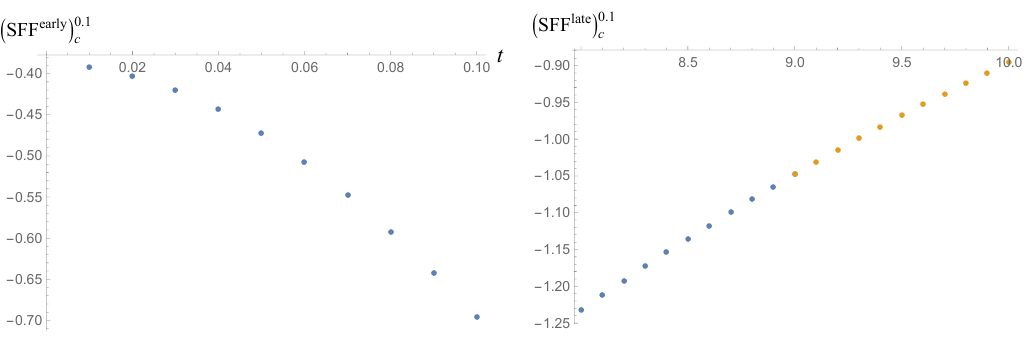
Figure 9 . Left: the non-perturbative correlator for (cid:22) = 1 ; (cid:12) = 0 : 1 ; q = 0 : 1 as a function of the time t . It exhibits an initial dip transitioning into a smooth ramp behaviour.